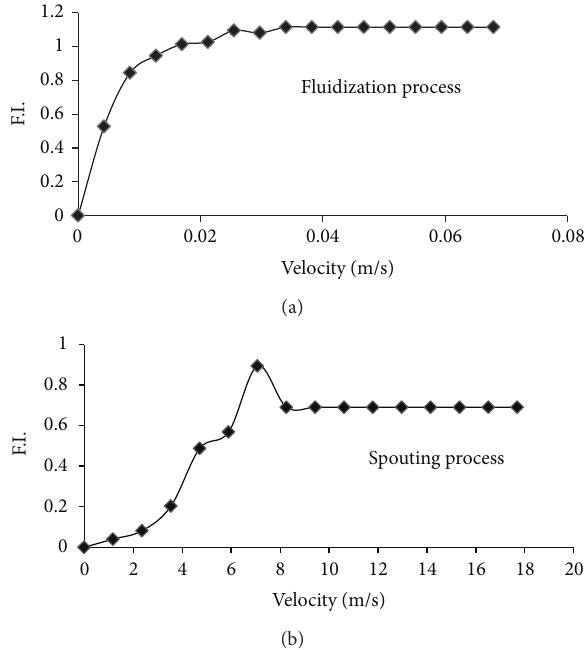
Figure 7: Correlation plot of bed expansion ratio against system parameters for fine